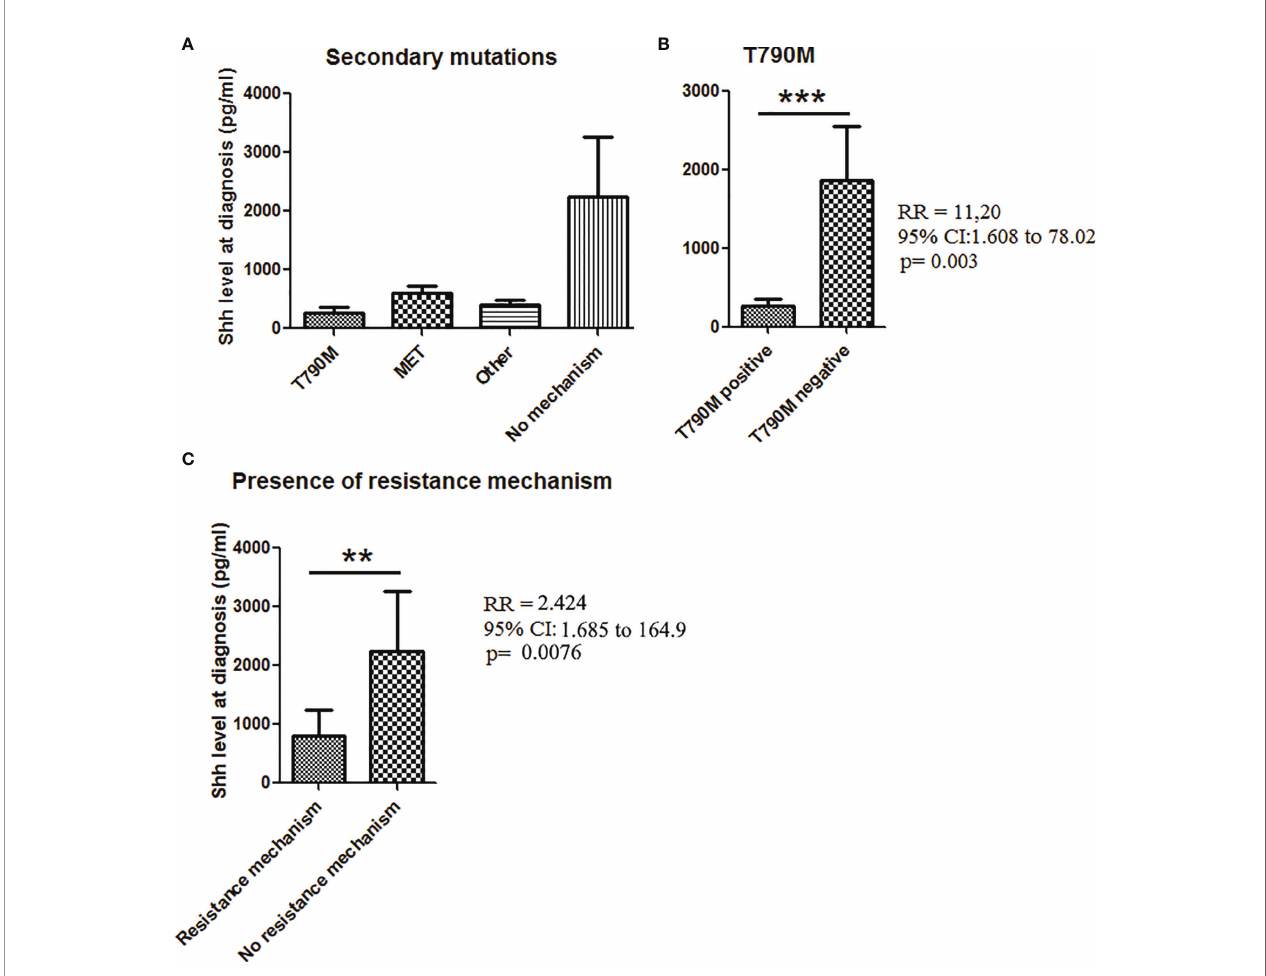
FIGURE 5 | Shh concentrations in plasma from patients at diagnosis according to the presence of secondary mutations. (A) Patient samples analyzed for Shh expression at baseline were classi fi ed according to the progression mechanism observed at the time of the progression. (B) Association between Shh concentrations and the presence of T790M mutation at the time to the progression. (C) Shh concentration in plasma from patients according to the presence of a resistance mechanism. A Mann – Whitney test was used to analyze the differences between means. ** p < 0.01; *** p <